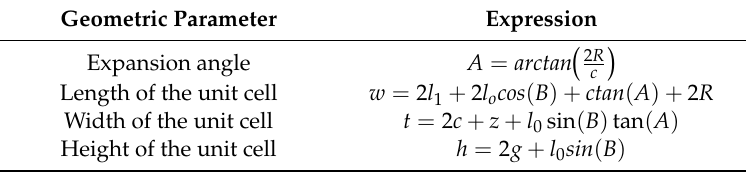
Table 1. Interdependence between geometric parameters for the investigated